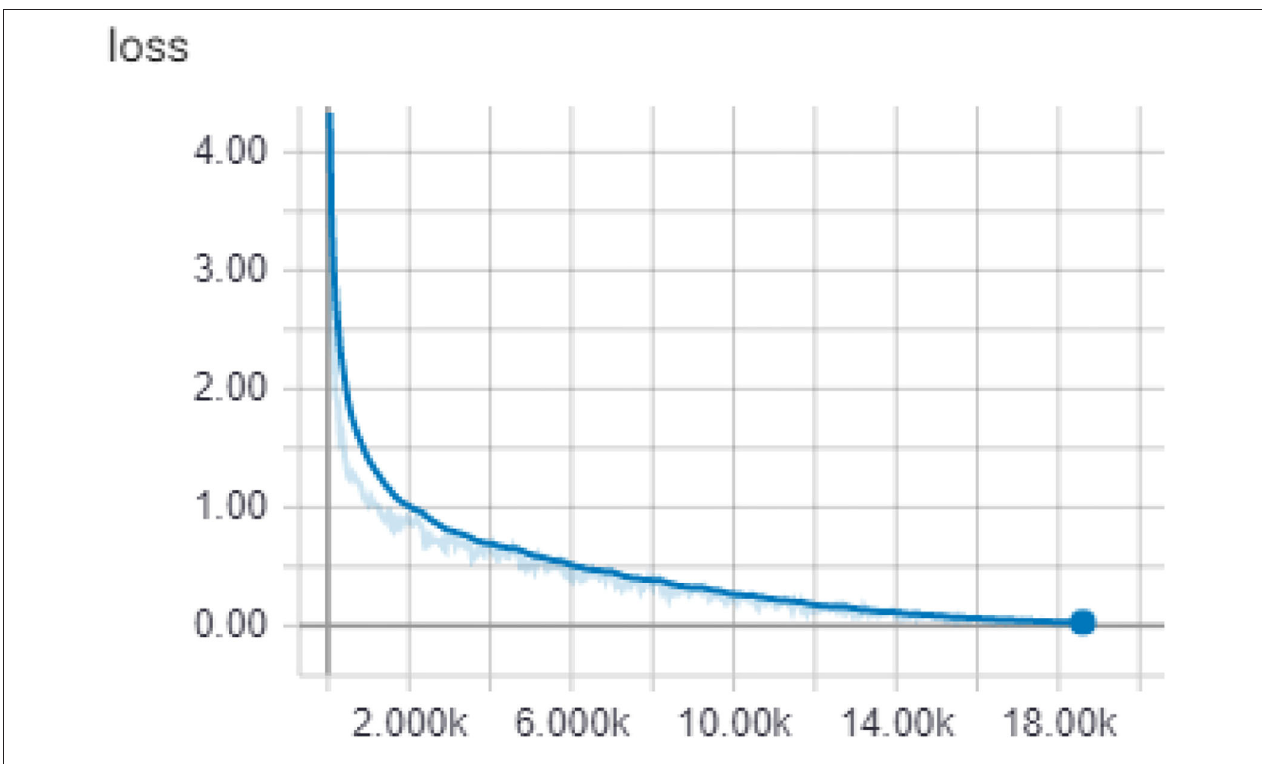
FIGURE 17 | Loss score curve.